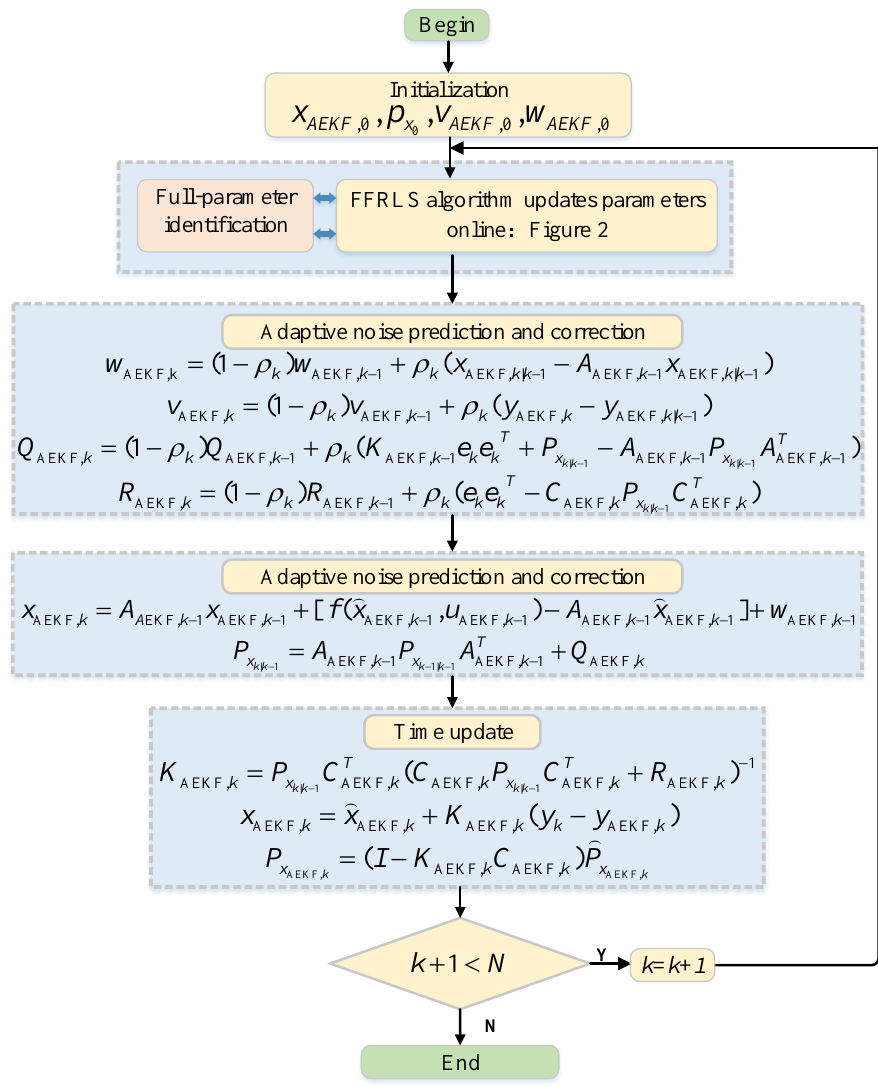
Figure 3. AEKF algorithm to estimate SOC flow chart.